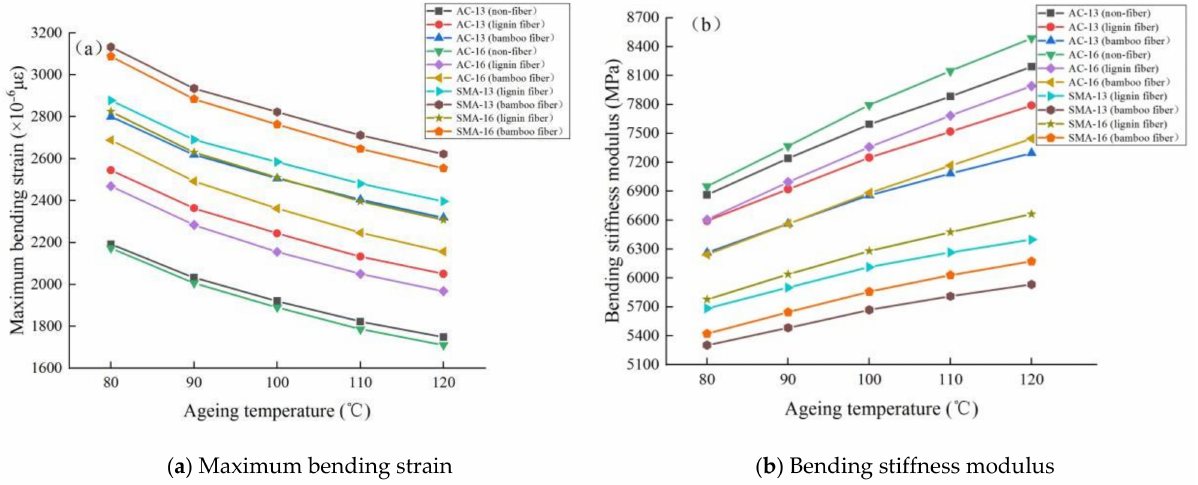
Figure 8. Low-temperature performance test results of fiber asphalt mixture under different ageing